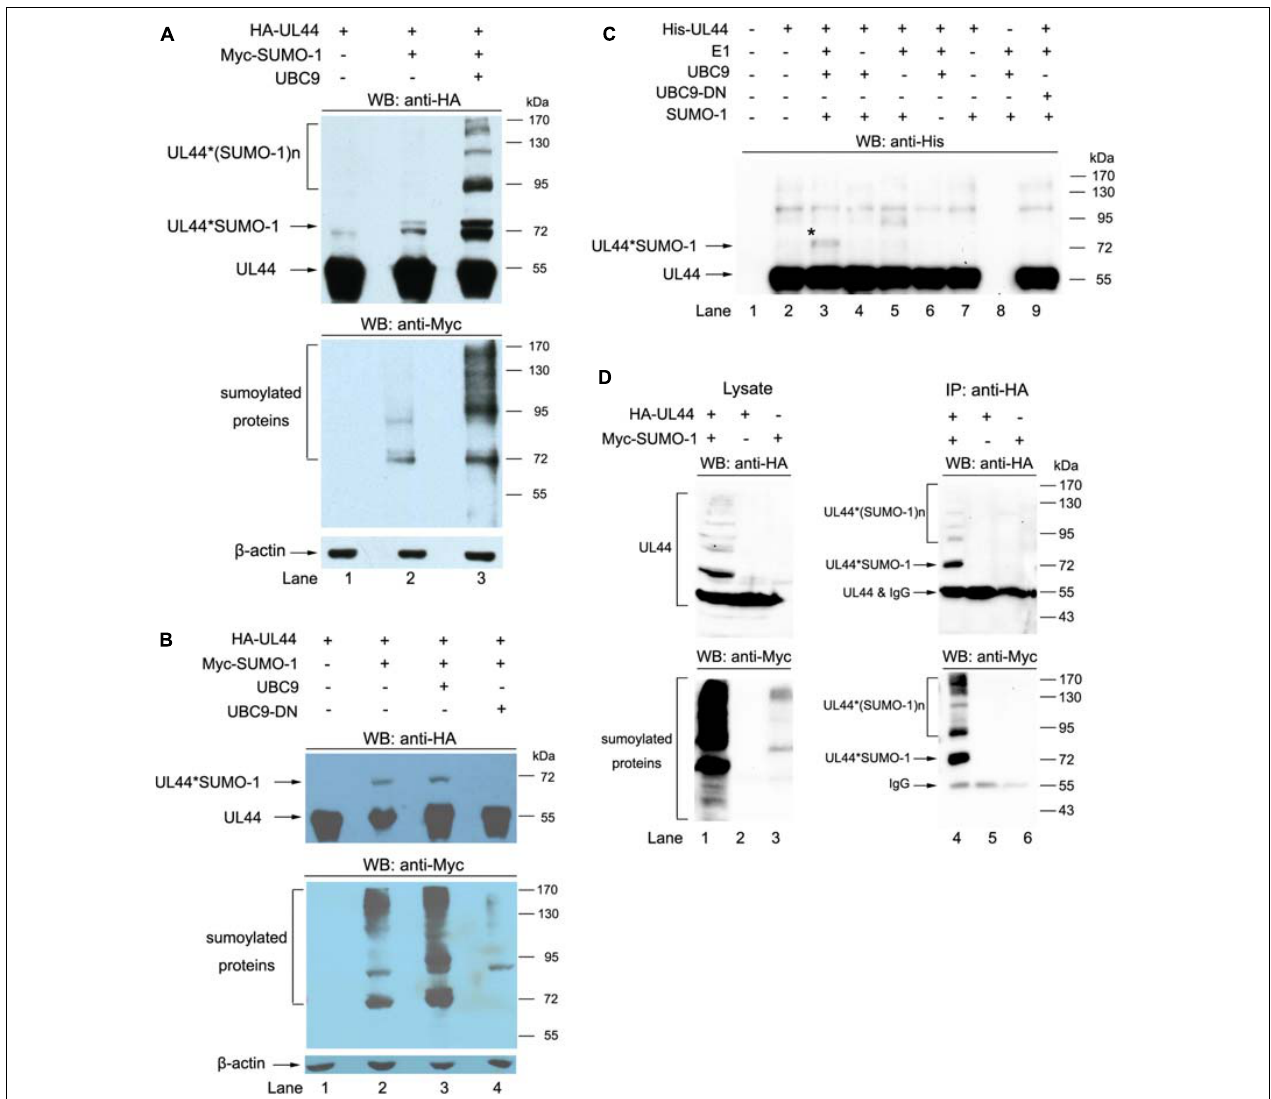
FIGURE 3 | UL44 is a target for sumoylation. (A) UL44 covalently conjugated with SUMO-1. 293T cells were transiently cotransfected with HA-UL44, Myc-SUMO-1 and UBC9 as indicated. Forty eight hours later, cells were resuspended and boiled in SDS sample buffer, the supernatants were analyzed by western blot using anti-HA and anti-Myc antibodies. β -actin served as loading control. (B) UBC9 dominant-negative mutant abolished the sumoylation of UL44. 293T cells were cotransfected with HA-UL44, Myc-SUMO-1, UBC9, or UBC9-DN as indicated, and then processed the same as in (A) . (C) UL44 covalently conjugated with SUMO-1 in vitro . Purified His-tagged UL44, SUMO-activating E1 enzyme, UBC9, UBC9 dominant-negative mutant, and SUMO-1 were mixed in reaction buffer and incubated at 37 ◦ C for 2 h. The mixtures were separated by SDS-PAGE and UL44 was detected with anti-His antibody. (D) UL44 co-IPed with SUMO-1. Lysates from 293T cells expressing HA-UL44 and Myc-SUMO-1 were immunoprecipitated by anti-HA, the results were analyzed by western blot using anti-HA and anti-Myc antibodies. For all panels, representative of three independent